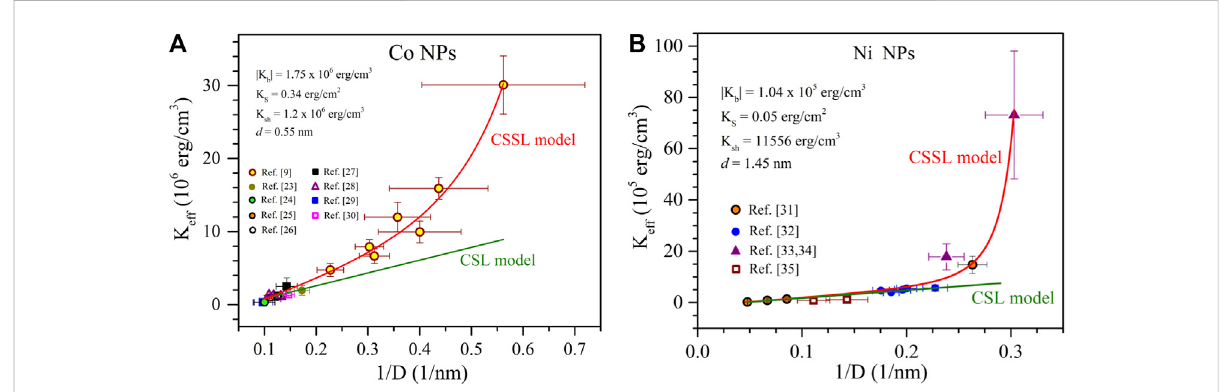
FIGURE 2 The K eff vs. 1/D variation of (A) Co, and (B) Ni NPs. The red (green) line shows the best fi t to the CSSL (CSL) model. The best fi tting parameters